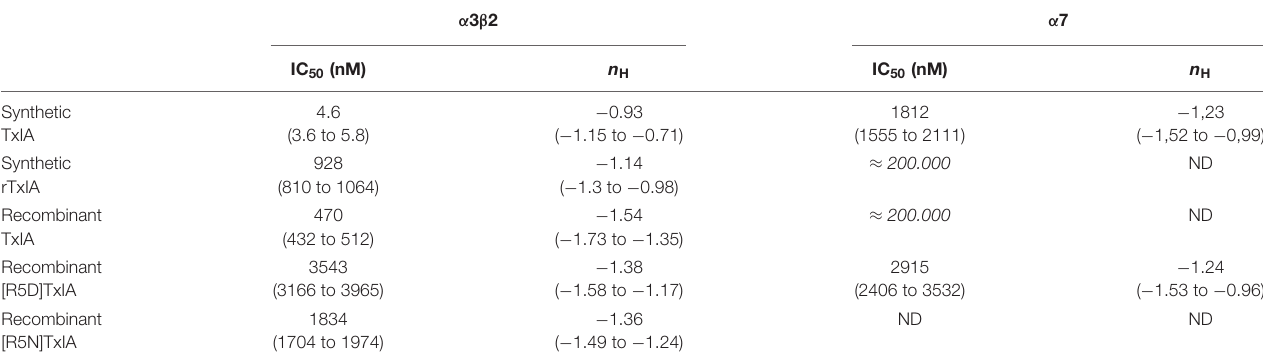
FIGURE 3 | Potency comparison of synthesized amidated and expressed non-amidated TxIA on nAChR subtypes. (A) Reduction of control responses activated by 100 µ M ACh or nicotine (in case of α 7 nAChR) by 1 µ M synthetic (syn) or recombinant TxIA (rec = wild type; R5D and R5N amino acid substitutions) at the indicated nAChR subtypes expressed in Xenopus oocytes and measured using TEVC electrophysiology. (B) Concentration-response curves for synthetic and recombinant TxIA at α 3 β 2 (left) and α 7 (right) nAChRs. Error bars represent the SEM from at least three recordings [except for high ( > 10 µ M) concentrations of synthetic peptides, where not enough material was available]. Oocytes were clamped at –70 mV. 100 µ M ACh or 100 µ M nicotine were used to activate α 3 β 2 and α 7 receptors, respectively. TABLE 1 | IC 50 values and Hill coefficients ( n H ) for synthetic TxIA and recombinant TxIA, [R5D]TxIA, and [R5N]TxIA at rat α 3 β 2 and α 7